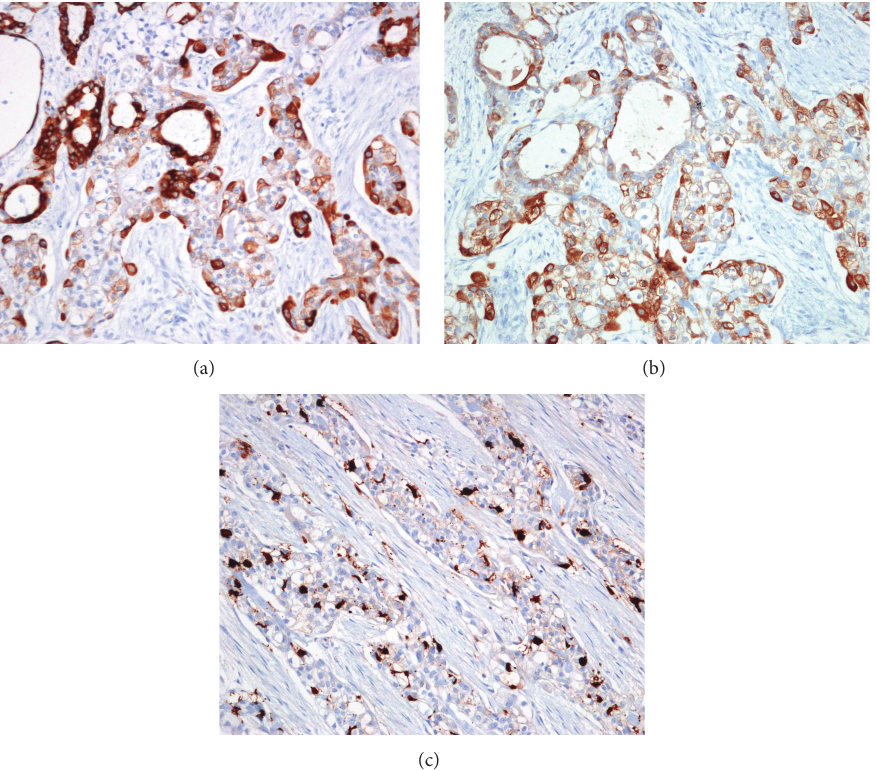
Figure 3: Immunohistochemistry of the tumor. Immunohistochemical analysis revealed that the tumor cells were strongly positive for